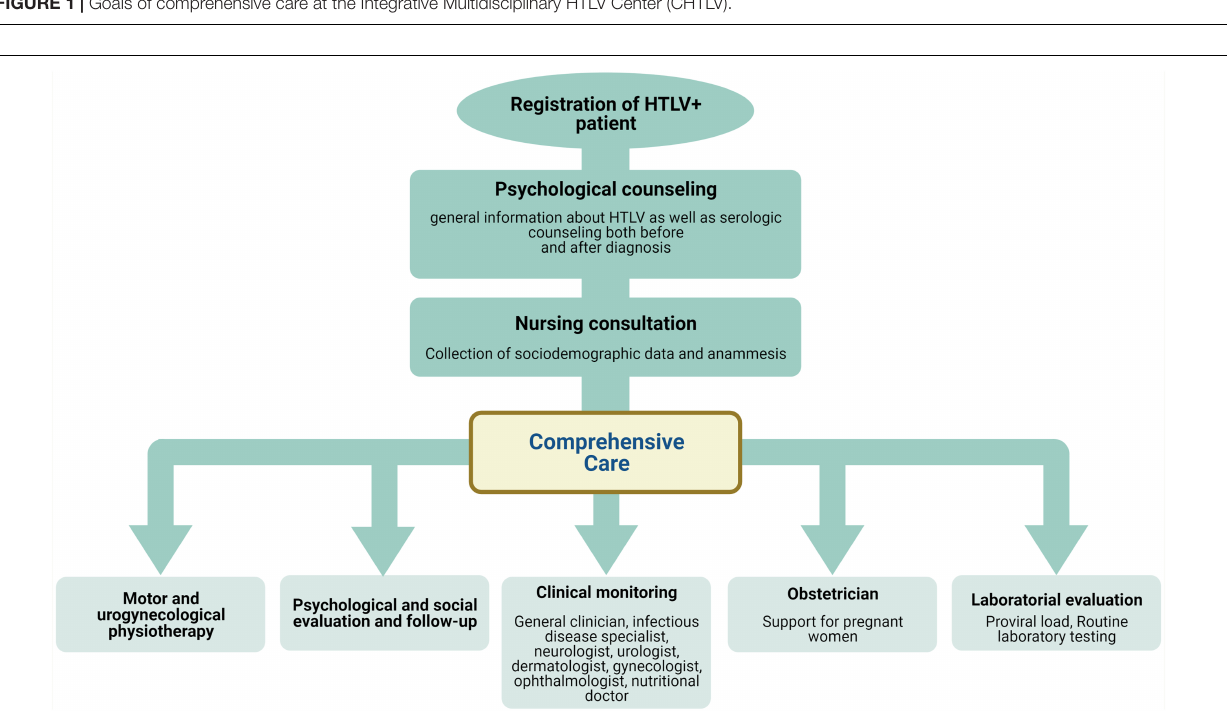
FIGURE 1 | Goals of comprehensive care at the Integrative Multidisciplinary HTLV Center (CHTLV).